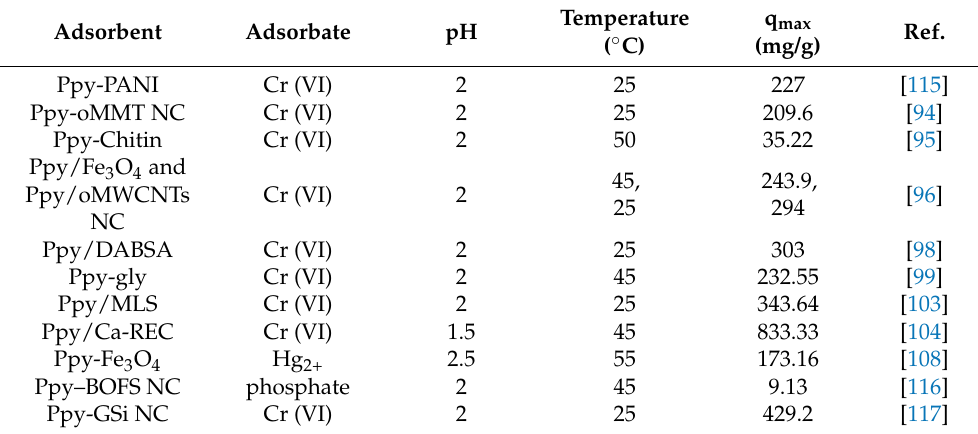
Table 4. Ppy-based adsorbents for the removal of